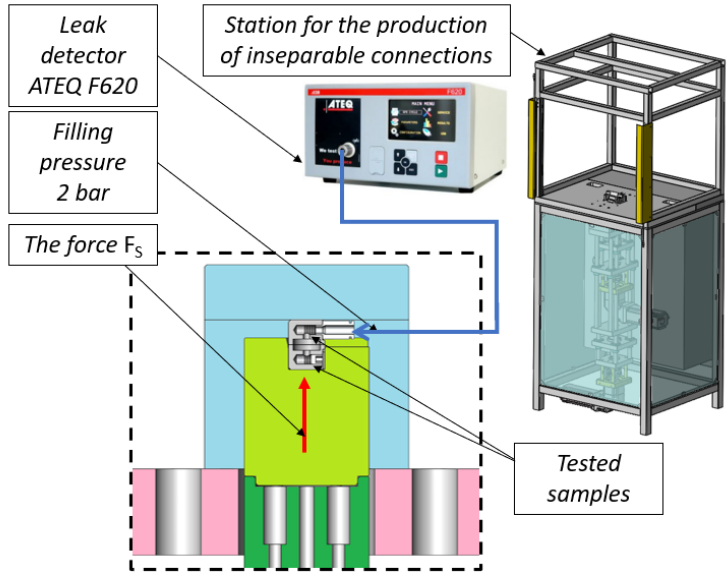
Figure 5. Diagram of the stand for testing the tightness of samples. Table 5. Ranges of the device for measuring the pressure drop ∆ P where dP is the measured value of the pressure drop, with permission from Ref [31], 2022,